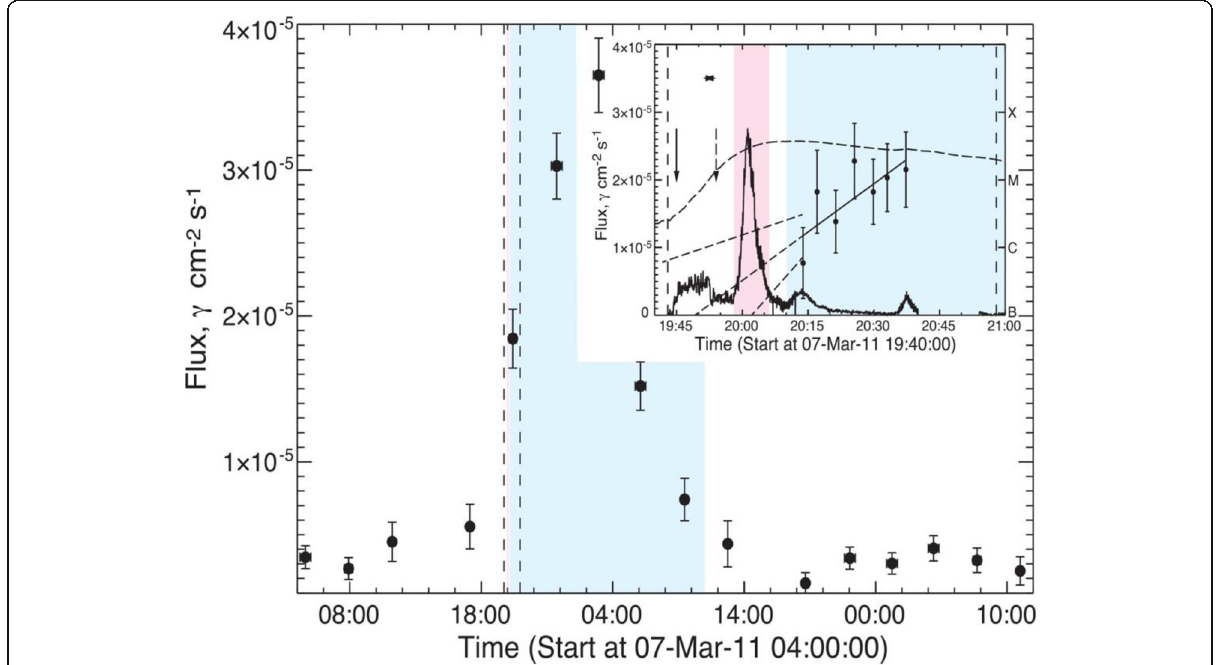
Fig. 20 Main plot: Time history of the > 100 MeV light-bucket fluxes from < 10° of the Sun, revealing LPGRE from the 2011 March 7 solar eruptive event. Vertical dashed lines show the GOES 1 – 8 Å start and end times. Inset: 4 min accumulation light-bucket fluxes as detected by Fermi/LAT are shown. The dashed curve shows the GOES time history. The blue shaded region denotes the estimated duration of the LPGRE. The pink shaded region depicts where estimates of the flux of > 100 MeV impulsive-flare γ -ray emission were made (see text; after Share et al.